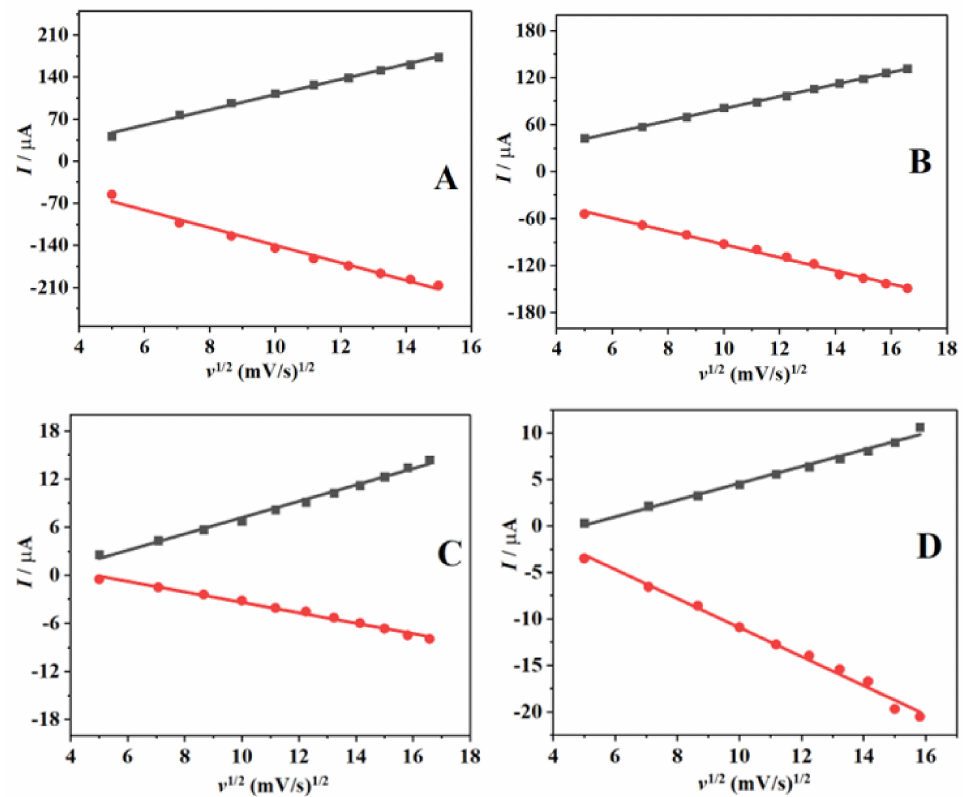
Figure 7. The linear relationship between I p and v 1/2 for ( A ) SPAuE, ( B ) SPAuE-CuO, ( C ) SPAuE- SPEEK, and ( D )